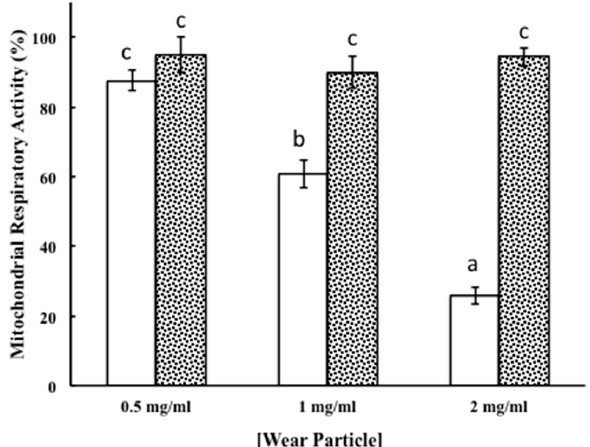
Figure 7. Mitochondrial respiratory activity of macrophages cell cultures exposed for 72 h to different doses of HCCoCr wear particles. Wear particles were obtained in PBS containing 3 g/L HA without (white bars) and with polarization (dotted black bars). Cell cultures were exposed to the following wear particles concentrations: 0.5, 1 and 2 mg/mL. Experiments were done as independent triplicate. Bars labeled with different letters show statistically significant differences and bars labeled with the same letter (c) show nonsignificant differences.